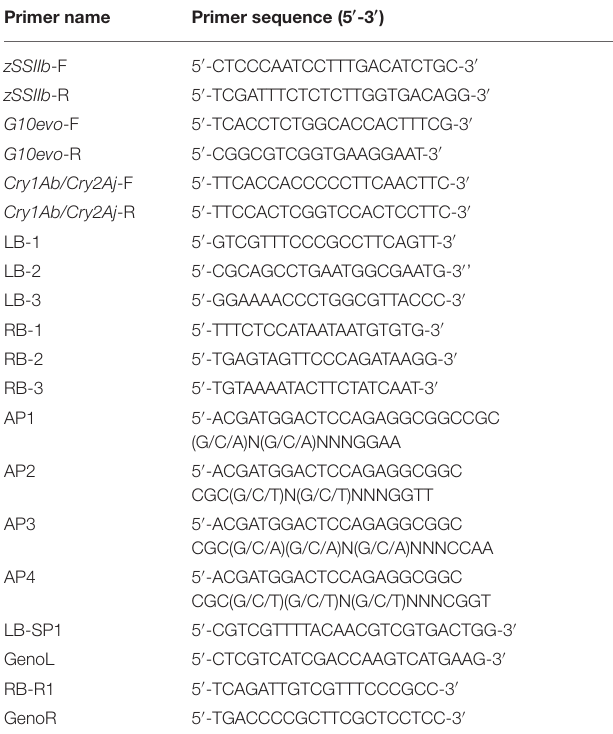
TABLE 1 | List of the primers used in this